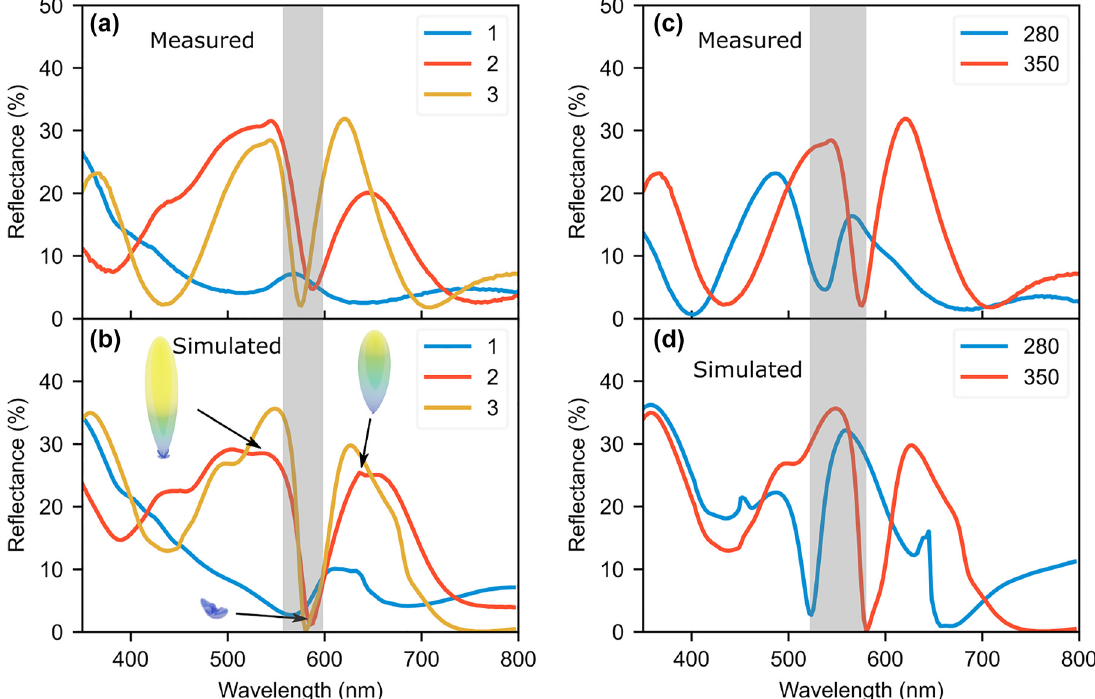
Figure 5: Specular reflectance of the disk stacks with AlGaAs diameter 350 nm and GaAs stem diameter 50 nm–100 nm. (a) Measured specular reflectance, the legend numbers indicate the number of disks in each stack. The corresponding simulated spectra are seen in (b), where the insets are the far field radiation plots for the reflected light in the two disk case. The far field plots are on the same scale, the size and color indicate magnitude of radiation. (c) Measured specular reflectance from three disk stacks with diameters 280 nm and 350 nm. (d) The corresponding simulated